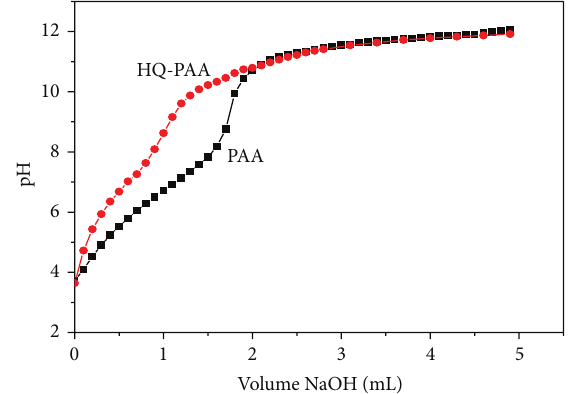
) for PAA and HQ-PAA. [NaNO NaOH